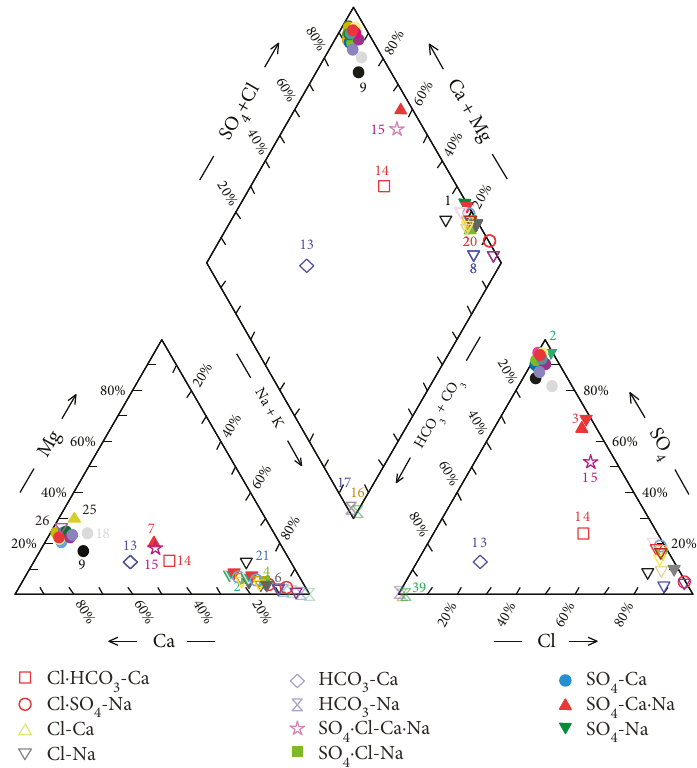
Figure 5: Piper diagram showing hydrochemical types of the saline and salty springs in the Sichuan